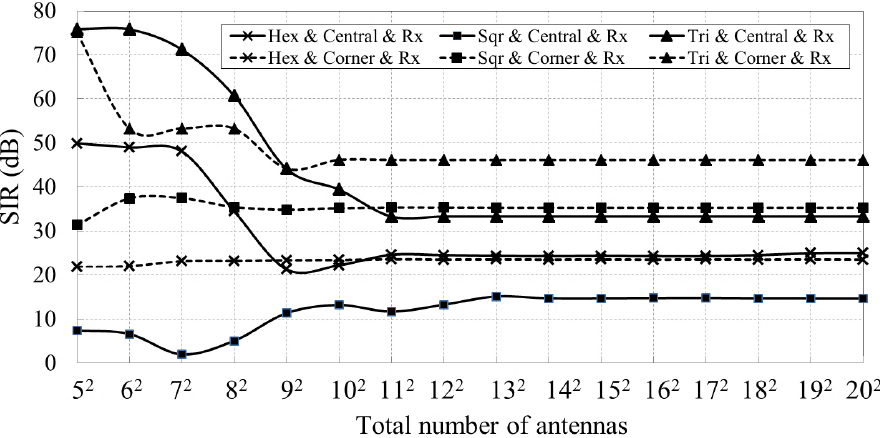
Figure 13. Received calibration signal’s SIR versus total number of antennas, where the solid lines show the calibration signal’s SIR when the central antenna is configured as a receiver. The dotted lines show the calibration signal’s SIR when the antenna at the top left corner is configured as